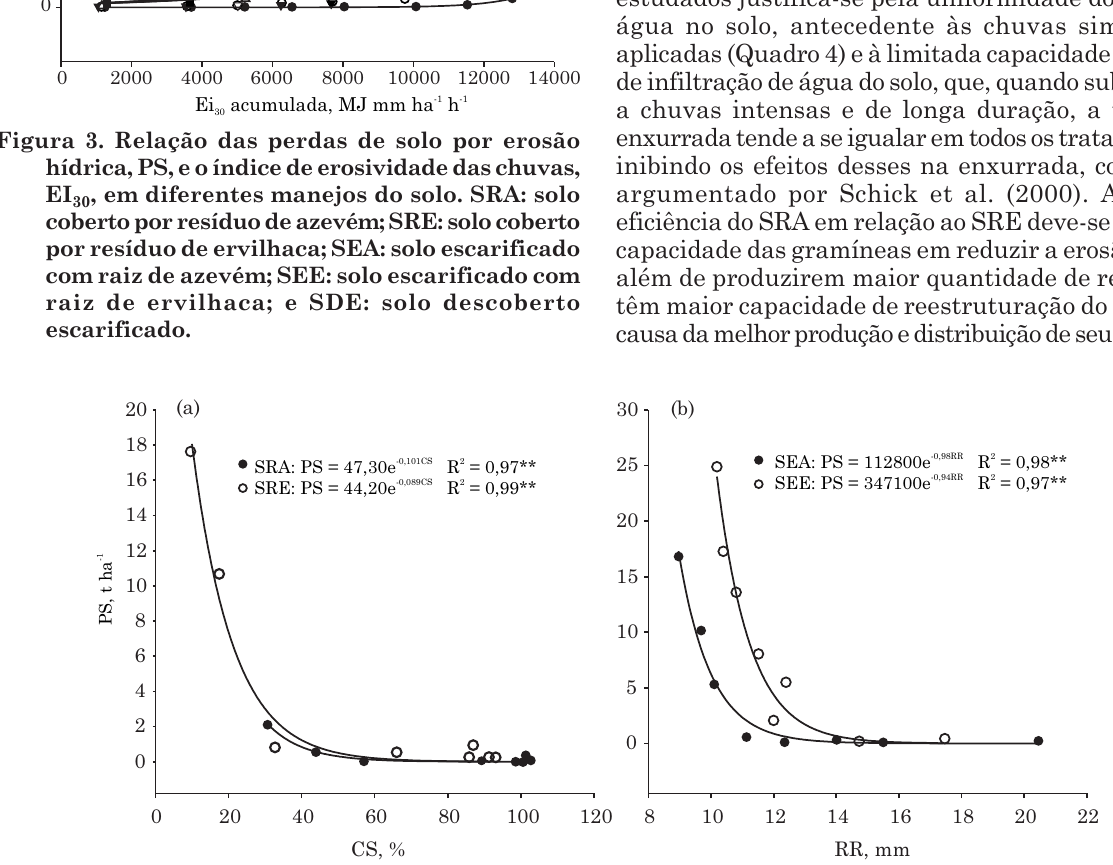
Figura 4. Relação das perdas de solo, PS, com a cobertura por resíduos culturais, CS (a), e com a rugosidade superficial ao acaso, RR (b), para os tratamentos: solo coberto por resíduo de azevém (SRA); solo coberto por resíduo de ervilhaca (SRE); solo escarificado com raiz de azevém (SEA); e solo escarificado com raiz de ervilhaca